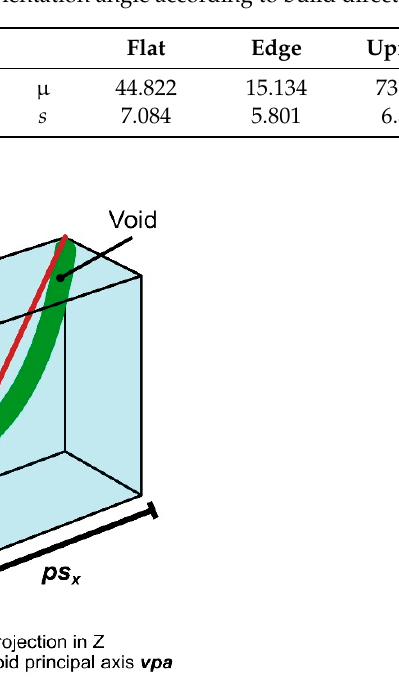
Figure 6. Void orientation angle α using x ( psx ), y ( psy ), and z ( psz ) void 1D projection measurements. Table 2. Mean ( μ ) and standard deviation ( s ) of void orientation angle according to build direction.